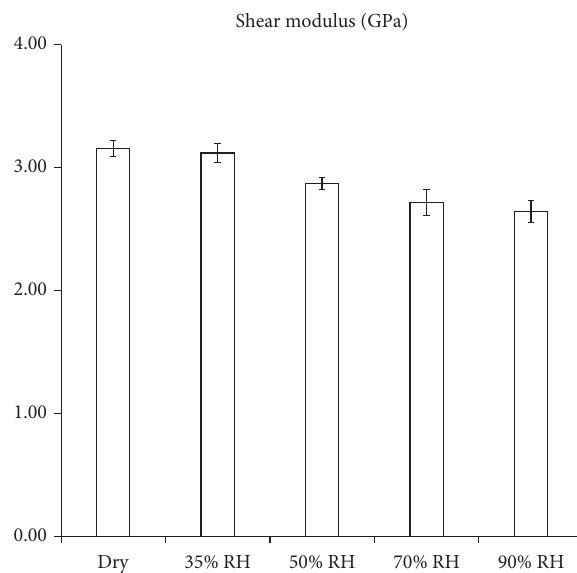
Figure 4: Shear modulus of the flax/epoxy composite samples.